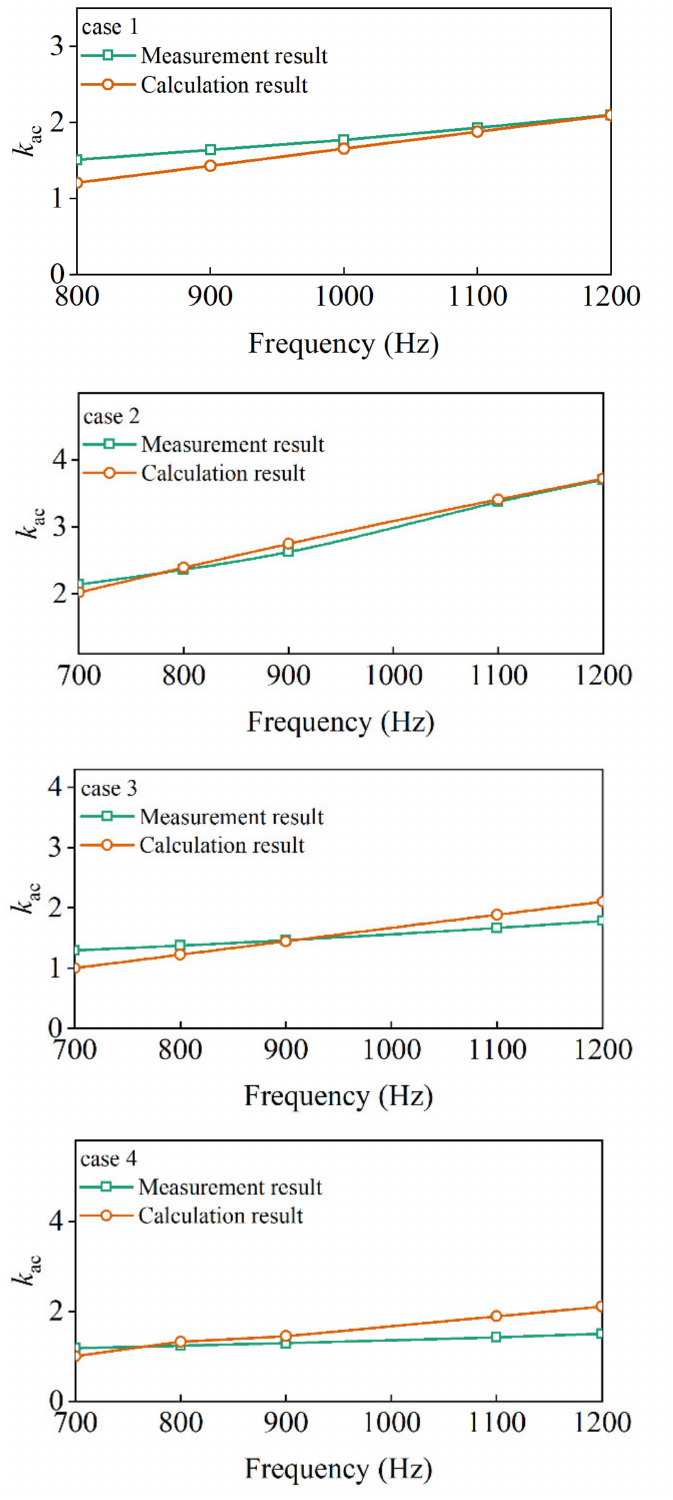
Figure 29. Test and calculation results at different